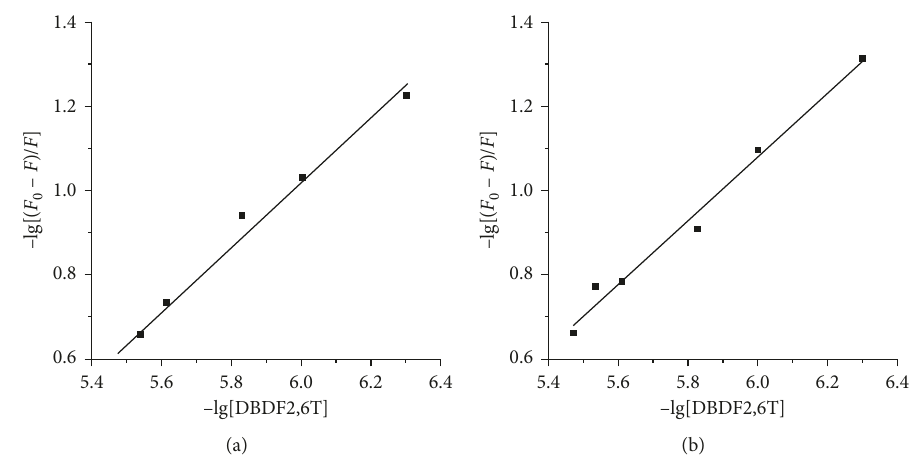
Figure 4: A plot of Table 2: Binding constants and the numbers of binding sites of hPPAR c protein with DBDF2,6T at different temperatures. Temperature T (K) Numbers of binding sites Binding constant, K A (L/mol)